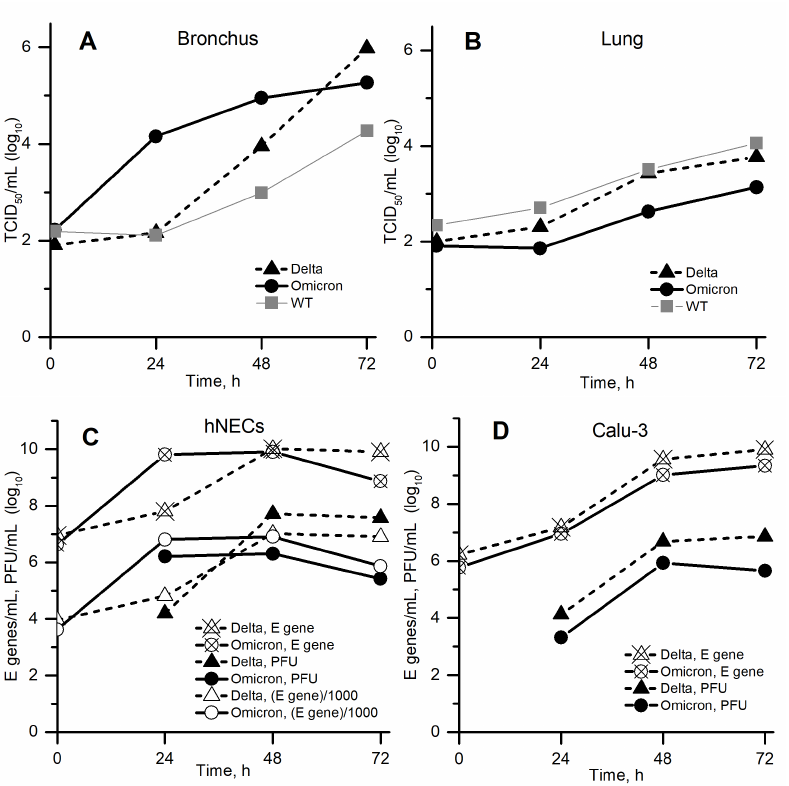
Figure 2. Viral replication kinetics: ( A , B ) in bronchus and lung cells [1]; ( C , D ) in nasal epithelial and human lung cells [2] (data were extracted from Figure 1 in preprint of [1] and from Figure 1 in preprint of [2]). ( C ) Open markers show E gene concentration (crossed markers) divided by 1000 to approximately match the corresponding PFU